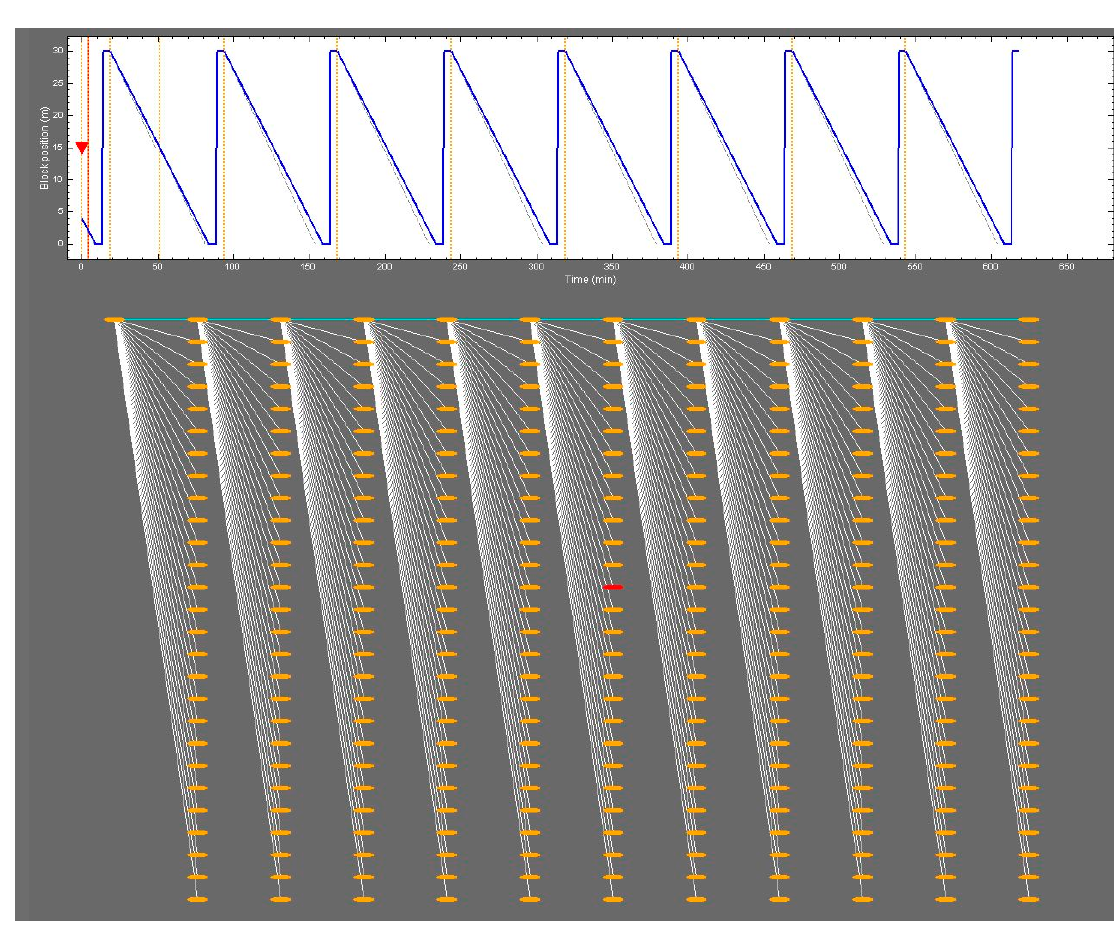
Figure 11. An alternative drilling plan to the one of Figure 10. The state reached after the 6th stand differs. Then, the remaining actions suggested by the system are also affected.